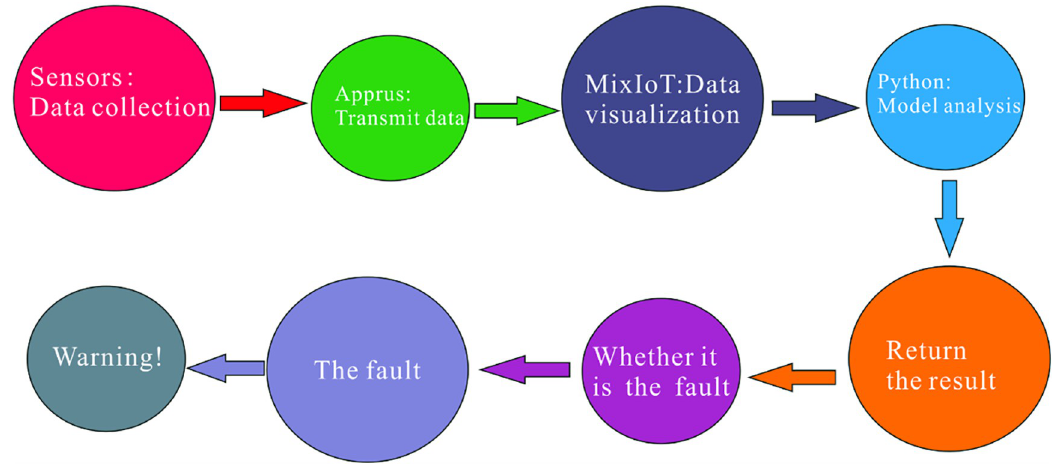
Fig 4. Work flow